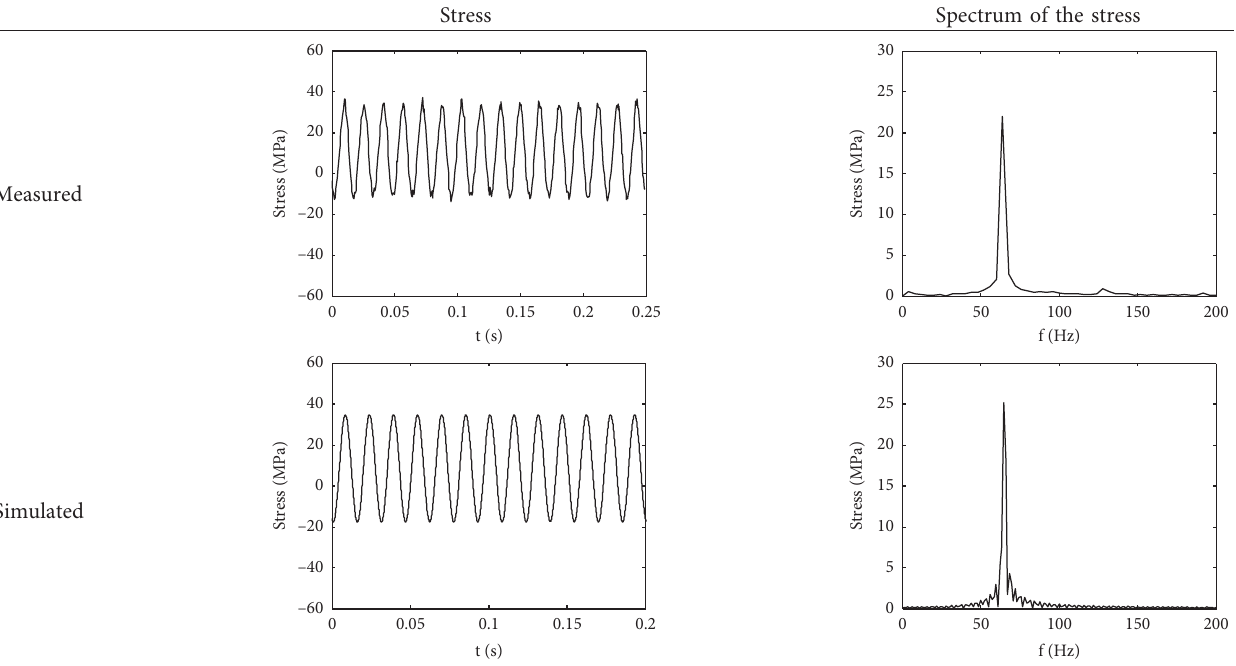
Table 10: Comparison of stress on the squirrel cage under support 2 upward 1mm ( h � 1 mm).